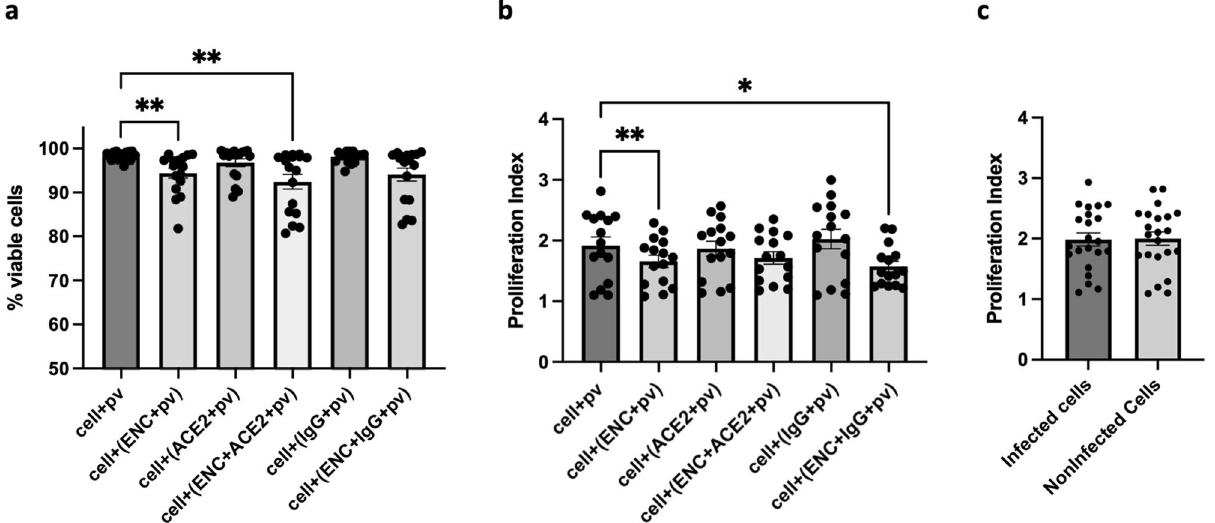
Figure 4. Viability and proliferation index was lower for cells in ENC. 293T-hsACE2 cells were inoculated with SARS-CoV-2 pseudovirus (pv) in conditions with and without endospermic nanocellulose (ENC) and molecular lures (ACE2 or anti-SARS-CoV-2 S IgG (IgG)) and incubated for 3 days. Cells were harvested for flow cytometry analysis. Statistical comparisons were made between positive controls (cells + pv) and other conditions. ( a ) % of viable cells was calculated for each condition (n = 16, ** p < 0.01, Kruskal–Wallis test, median with interquartile range). ( b ) Proliferation index was measured by CellTrace Violet™ dye dilution for all conditions (n = 15, * p < 0.05, ** p < 0.01, ANOVA, mean ± SEM) and c. Proliferation index was compared between infected and noninfected cells in positive controls (cells + pv)(n = 22, p = 0.812, ANOVA, mean ±